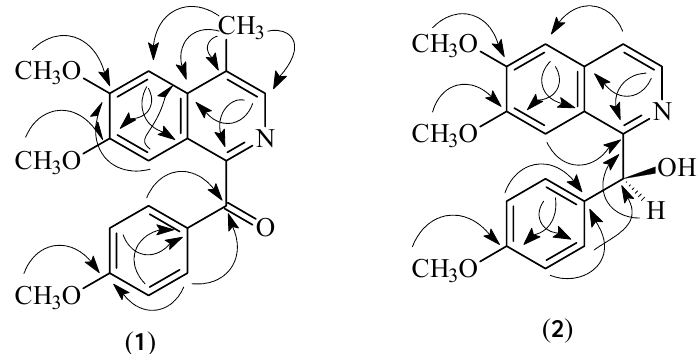
Figure 2. Selected HMBC correlation of alkaloids ( 1 ) and ( 2